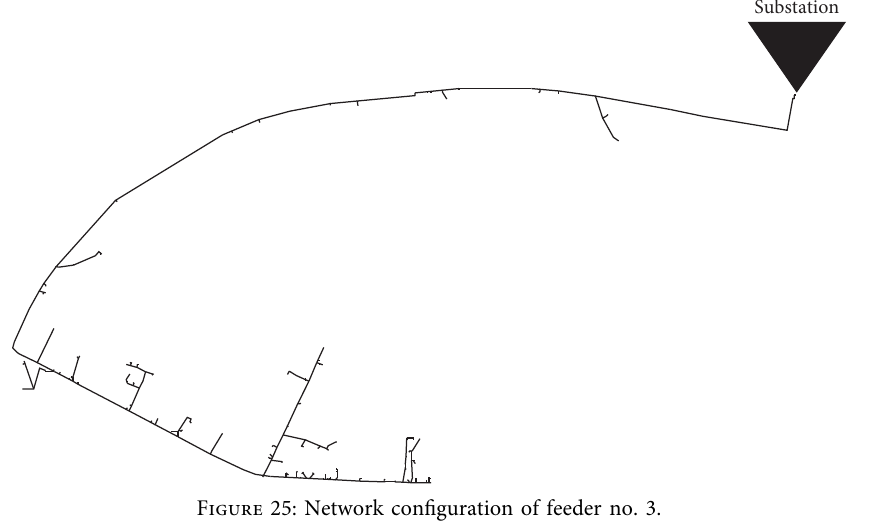
Figure 25: Network confguration of feeder no. 3.